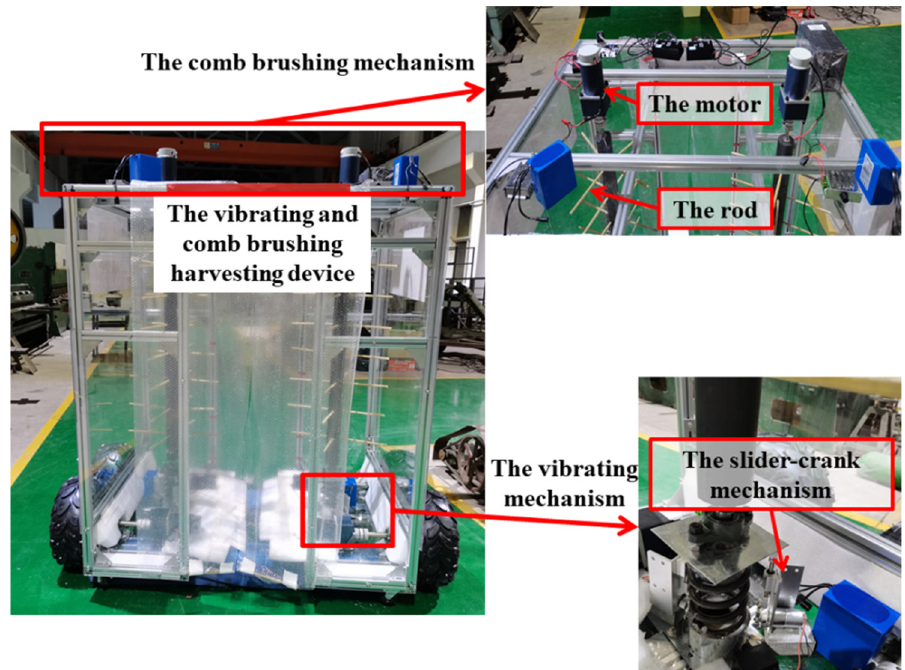
Figure 3. The vibrating and comb-brushing harvesting device.